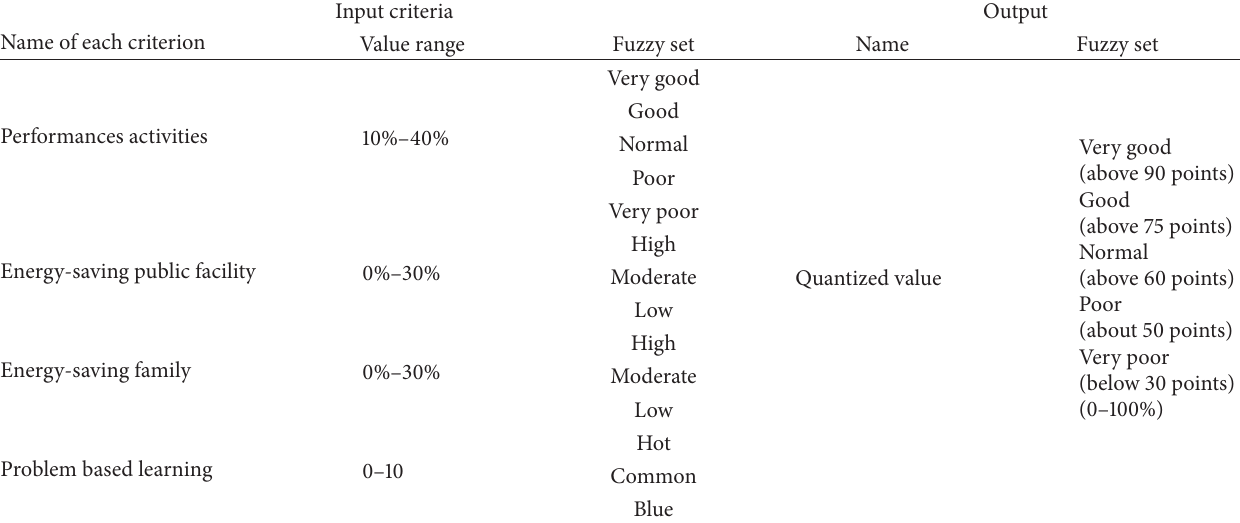
Table 3: Fuzzy set range definition of input and output criteria of community